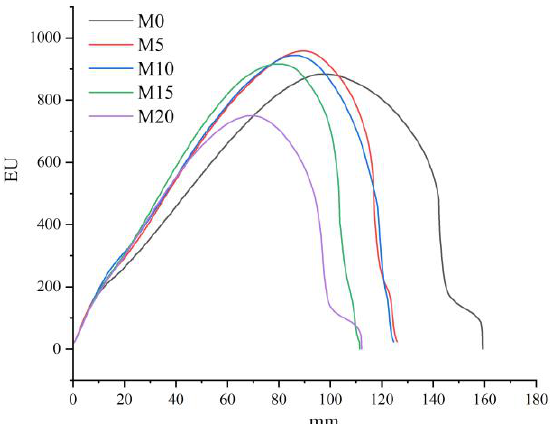
Figure 3. Extensograph curves of high-gluten wheat dough formulated with 0% (M0), 5% (M5), 10% (M10), 15% (M15), and 20% (M20) mealworm powder with a resting time of 45 min. EU: extensograph units. Table 4 . Extensograph and texture properties of high-gluten wheat flour with 0% (M0), 5% (M5),